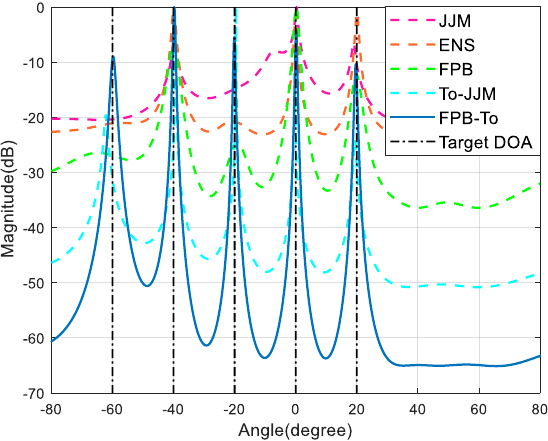
Figure 2. Comparison of spatial spectral curves.